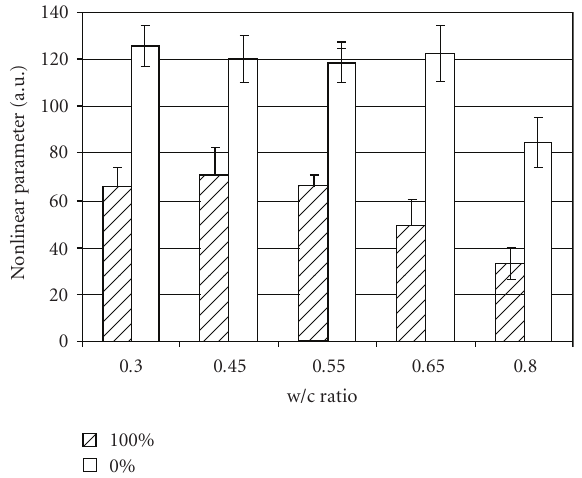
Figure 7: Nonlinear parameter measured at 0% and 100% saturation, as a function of the water to cement ratio.